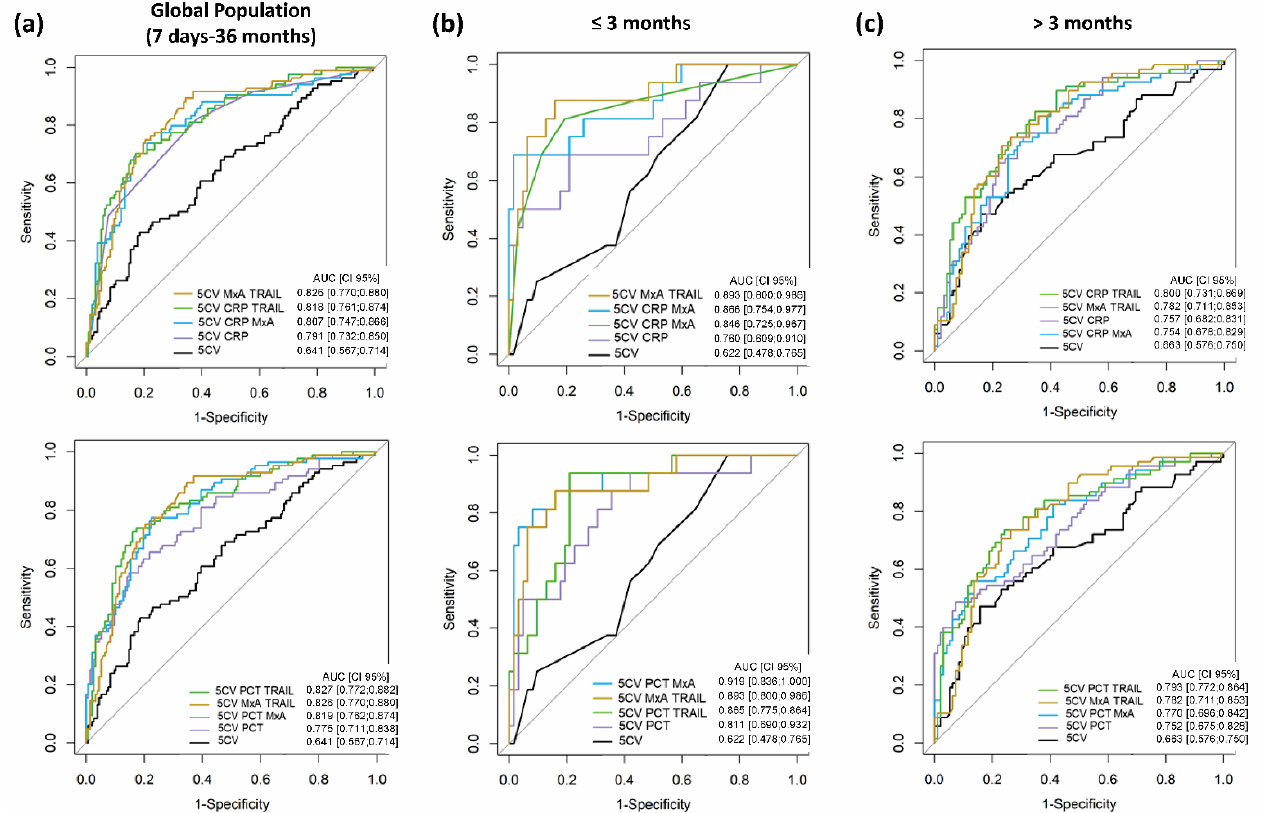
Figure 4. Performance of machine learning-based models including MxA and TRAIL together with clinical variables (TEST set). ROC curves and forest plots of best performing models including MxA and TRAIL are shown for the global population ( a ), the ≤ 3-month-old patients ( b ), and the >3-month-old patients ( c ). The upper ROC curves show the combinations with CRP and the lower ROC curves the combinations with PCT. The bad-performing model including clinical variables only (5CV) is depicted in black, and the good-performing model (5CV/MxA/TRAIL) is depicted in brown. Respective forest plots are shown in Figure 3. Complete performance results are shown in Table S7.